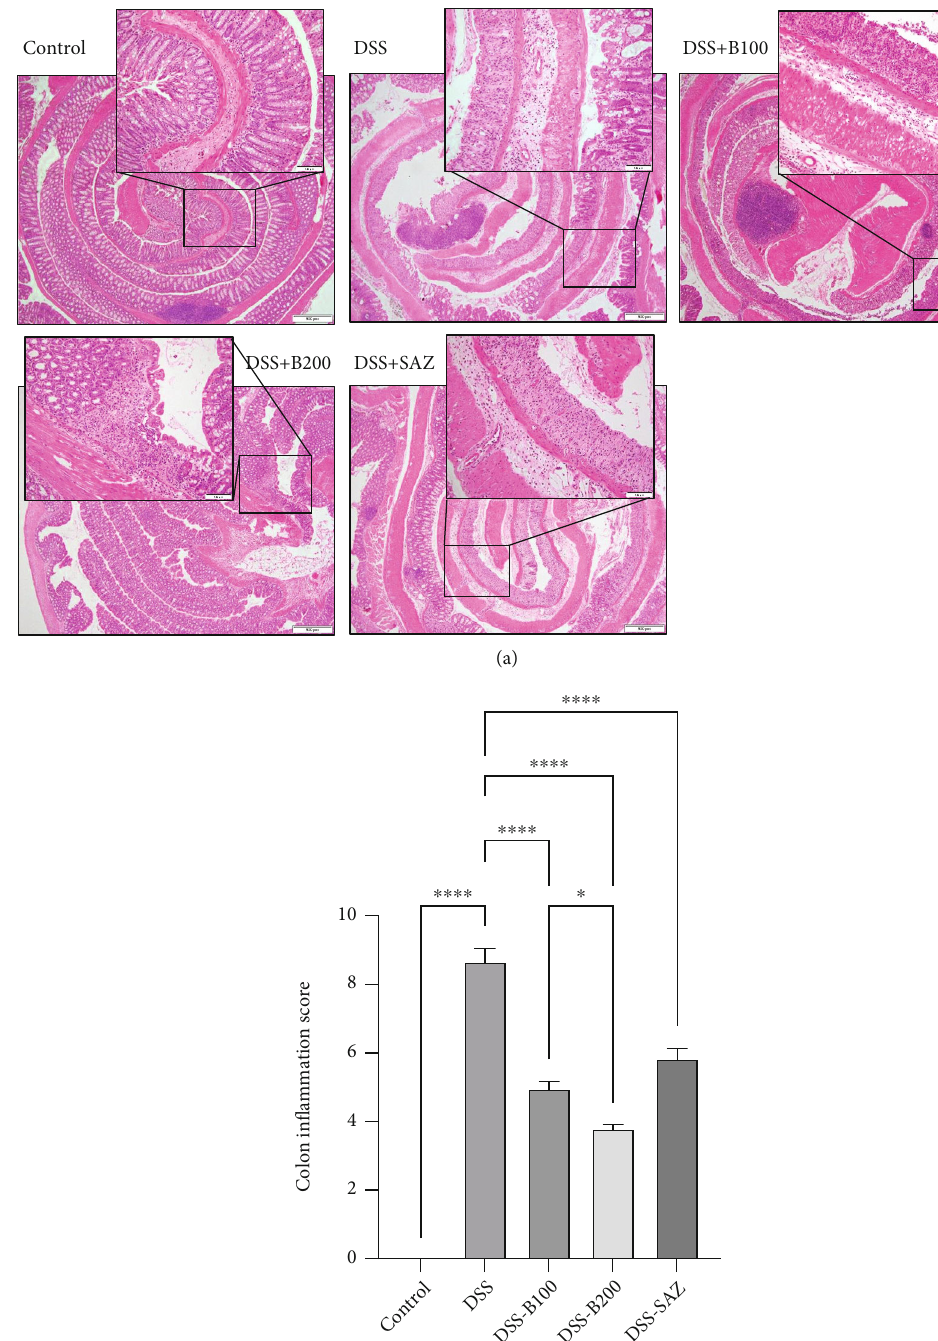
Figure 3: E ff ect of bisabolol on colon histology. The control colon microarchitecture shows healthy villi and crypts with normal submucosa and muscle layer. DSS administration resulted in focal loss of villi and crypt. The in fi ltration is reaching submucosa with thickening of muscle layer (a). α -Bisabolol treatment signi fi cantly protected the colon microarchitecture with a reduced in fl ammation score (b). Eight ( n = 8 ) animals were used in each group to construct colon in fl ammation scores based on the swiss roll technique. Data are expressed as mean ± SEM . ∗ p < 0 : 05 and ∗∗∗∗ p < 0 : 0001